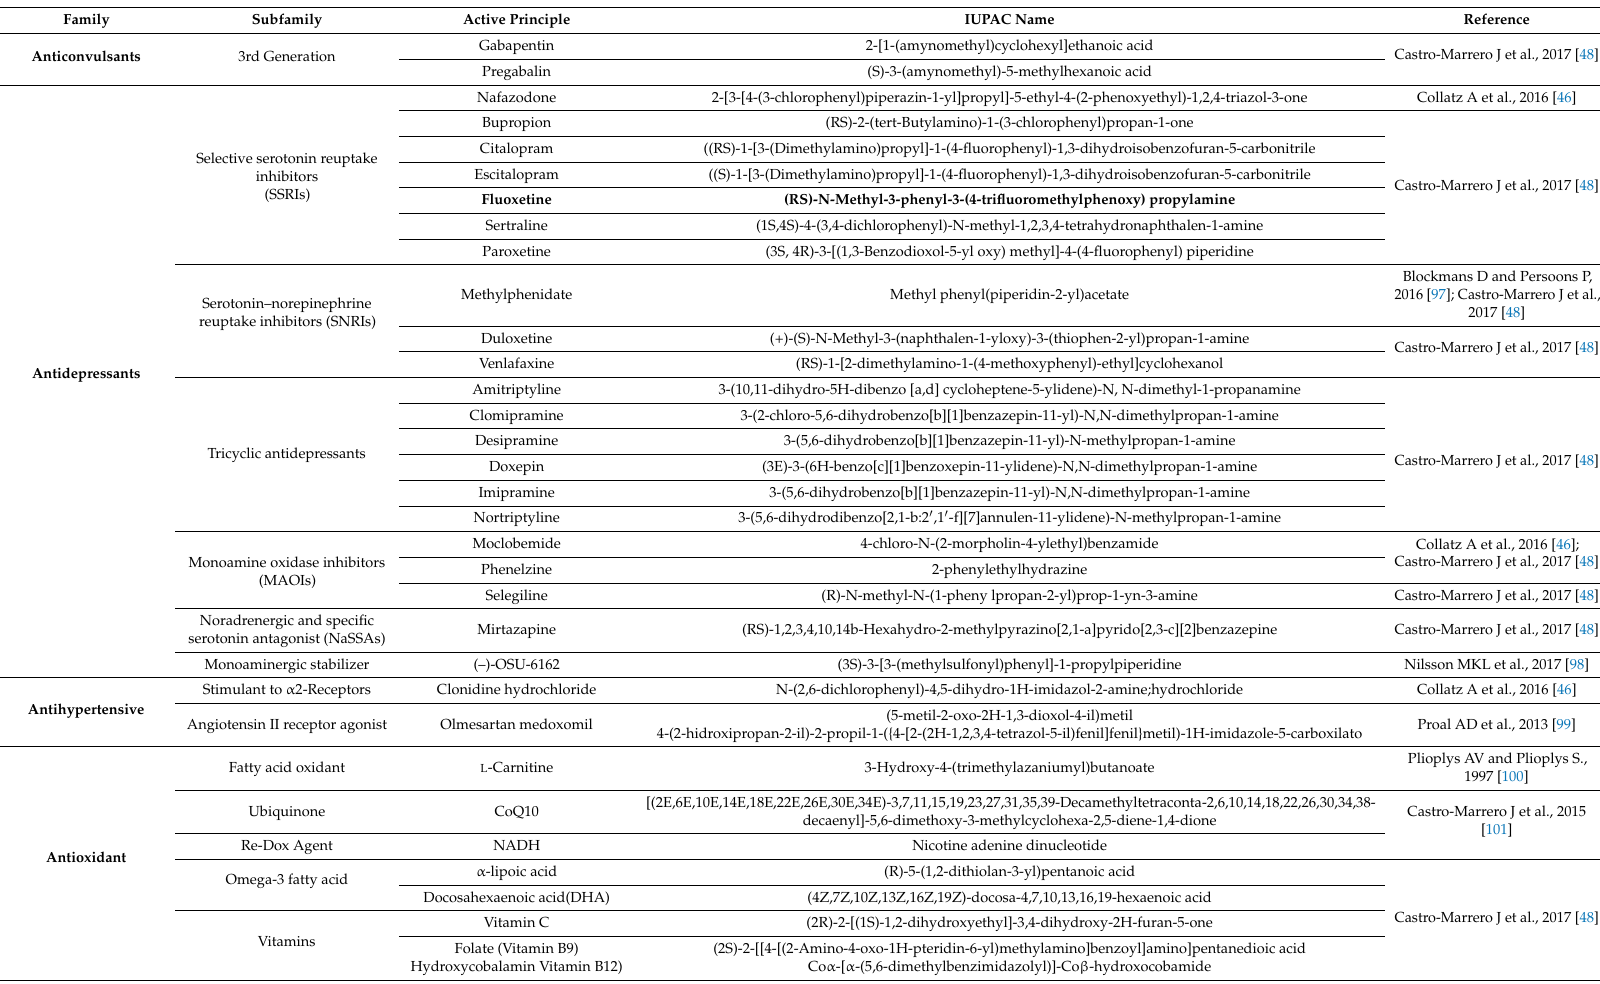
Table 4. Classification of drugs commonly prescribed to ME/CFS